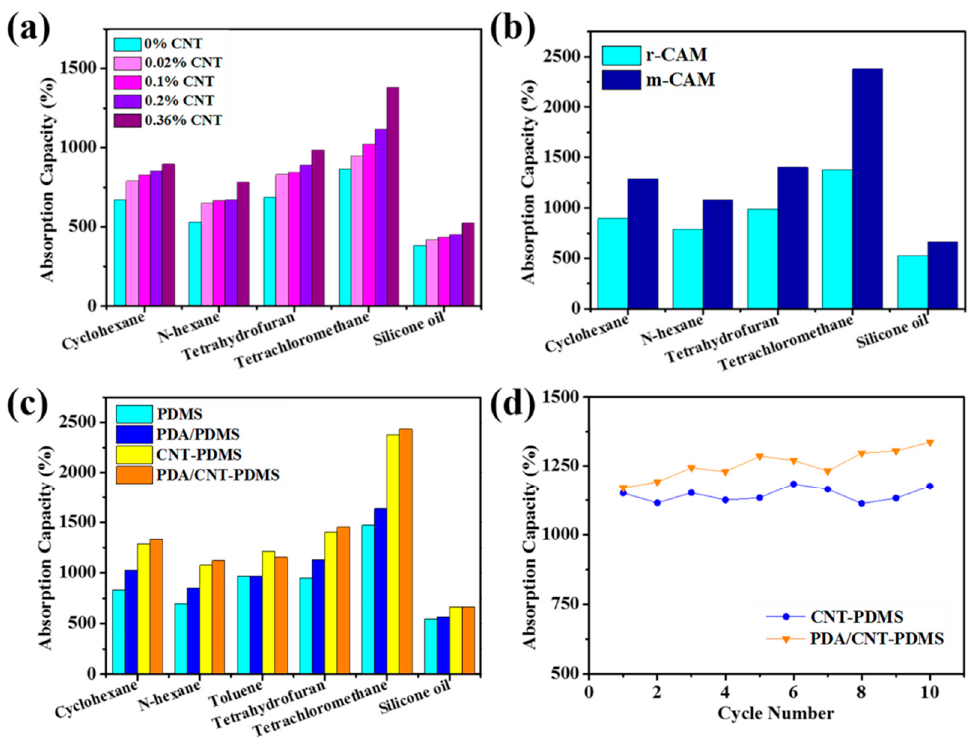
Figure 3. The influence of CNT content ( a ) and the particle size of CAM ( b ) on the absorption capacity of CNT-PDMS sponge for various organic solvents and oils. ( c ) The absorption capacity of PDMS, CNT-PDMS, PDA/PDMA, and PDA/CNT-PDMS sponges prepared with optimized condition for various organic solvents and oils. ( d ) Stability of CNT-PDMS and PDA/CNT-PDMS sponges with multi-recycles of cyclohexane absorption and removal.